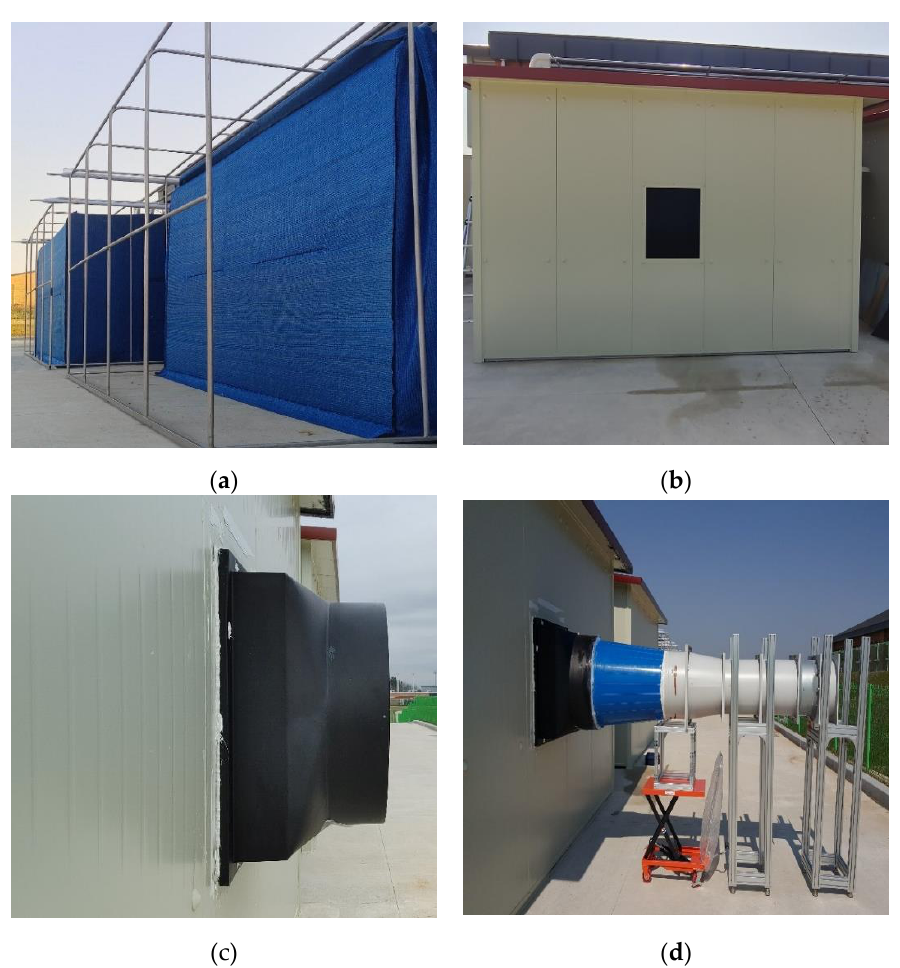
Figure 2. Curtain constructed on the outside of swine facility. ( a ) curtain, ( b ) metallic cover concealed the curtain, ( c ) single hole on the front of metallic cover, ( d ) ventilation measurement setup for air discharged through the single hole of metallic cover.